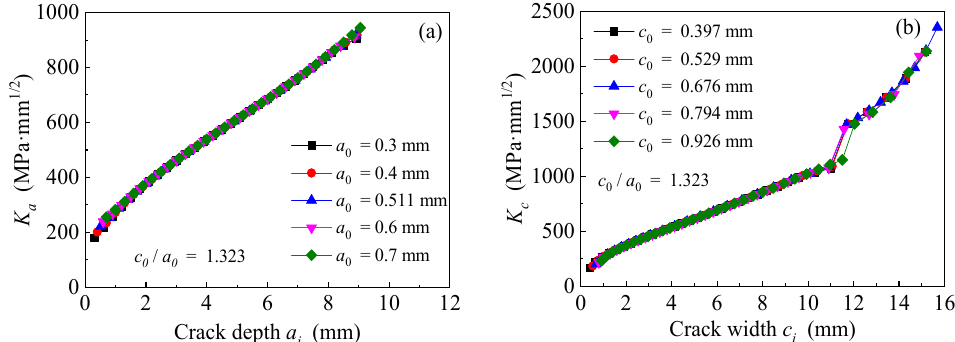
Figure 18. Effect of weight ‐ loss rate on ( a ) the crack propagation curves and ( b ) the fatigue life of the corroded steel plate strengthened with CFRP plates.